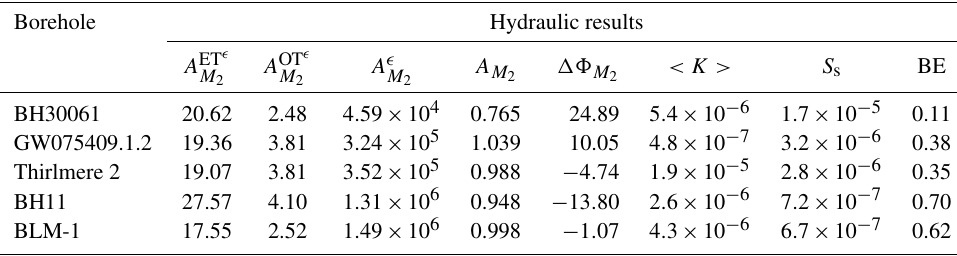
Table 3. Hydraulic results where A ET (cid:15) the strain response amplitude (m per nstr), A M ity (ms − 1 ), S s is the specific storage (1m − 1 ), and BE is the barometric efficiency (–).